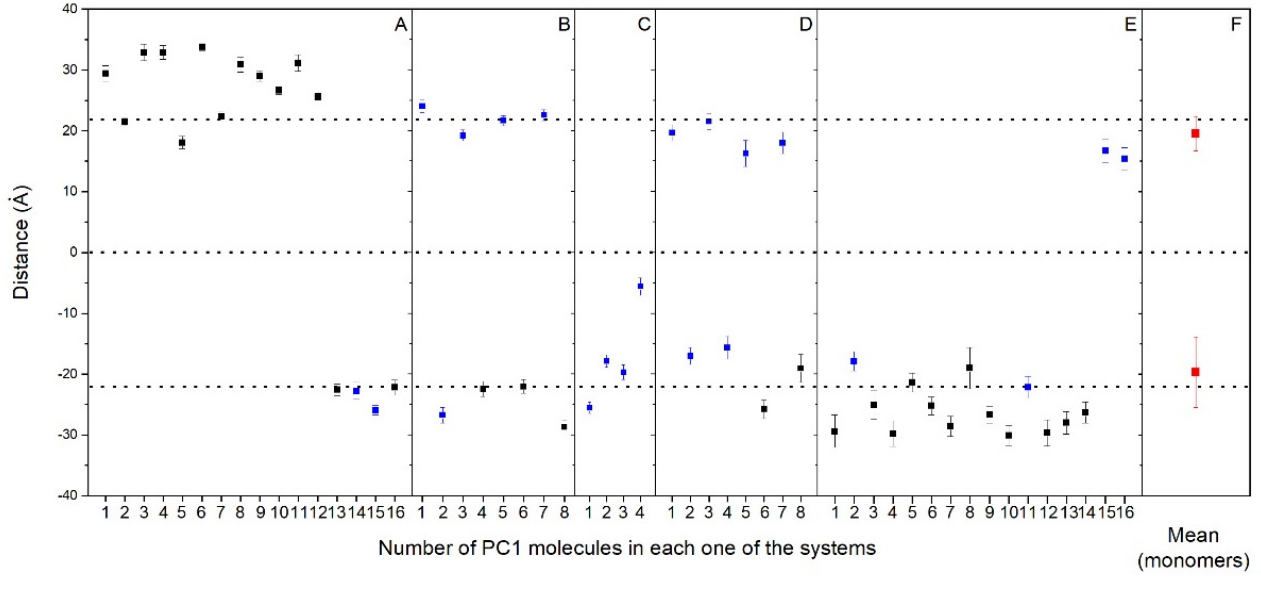
Figure 3. Average z -axis distance (middle of the membrane as a reference) for the different PC1 molecules and for the last 30 ns of the MD simulation in ( A ) system 1, ( B ) system 2, ( C ) system 3, ( D ) system 4, and ( E ) system 5. PC1 molecules in monomer ( ■ ) and oligomerized ( ■ ) states are shown. The mean plus standard deviation for all the PC1 molecules in the monomer state ( ■ ) is shown in ( F ). The dotted lines define the membrane surfaces and the center of the bilayer (phosphate atoms of the